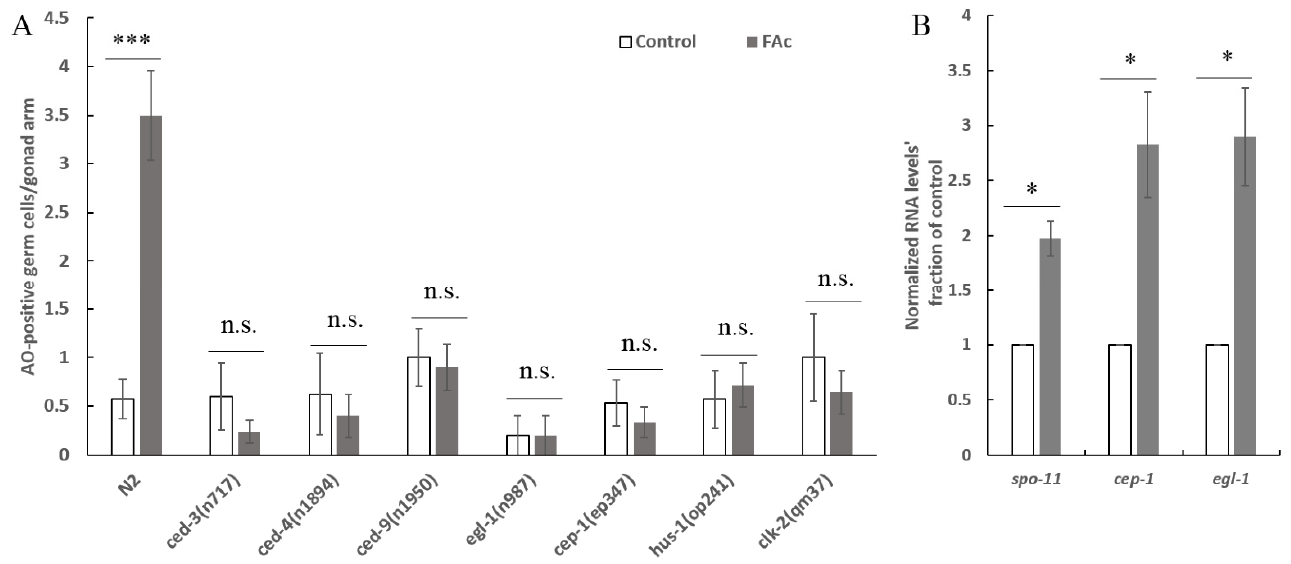
Figure 5. Molecular mechanism of FAc induced the germ-cell apoptosis of C. elegans . ( A ) Average number of acridine orange (AO)-positive germ cells per gonad arm in wild-type N 2 and C. elegans mutants after treatment with sterile water (control) or 200 mg/L FAc; data are shown as the mean ± standard error ( n ≥ 5). ( B ) qPCR analysis of the expression level of genes spo-11 , cep-1 , and egl-1 in wild-type C. elegans after treatment with 200 mg/L FAc or sterile water (Control). Gene pmp-3 served as a control; data are shown as the mean ± standard error ( n ≥ 3). * p < 0.05; *** p < 0.001; n.s. not significant; a two-tailed unpaired Student’s t test was used for statistical comparison between the values of the treatments and the control.